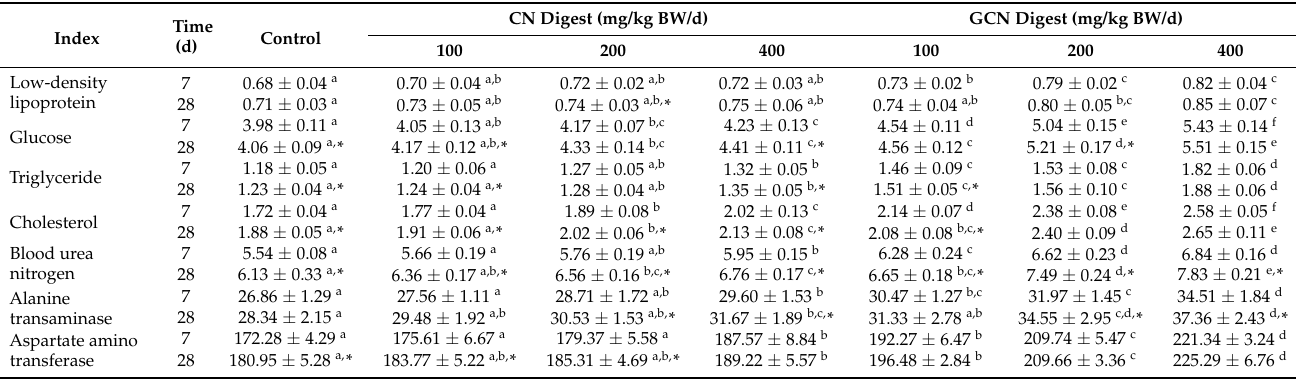
Values are reported as means ± standard deviations ( n = 6), while different lowercase letters after the values as the superscripts in the same row indicate that one-way ANOVA of the means differs significantly ( p < 0.05). Paired samples t test is used to determine the differences of the same index between 7 and 28 d, while the asterisk indicates data difference ( p <